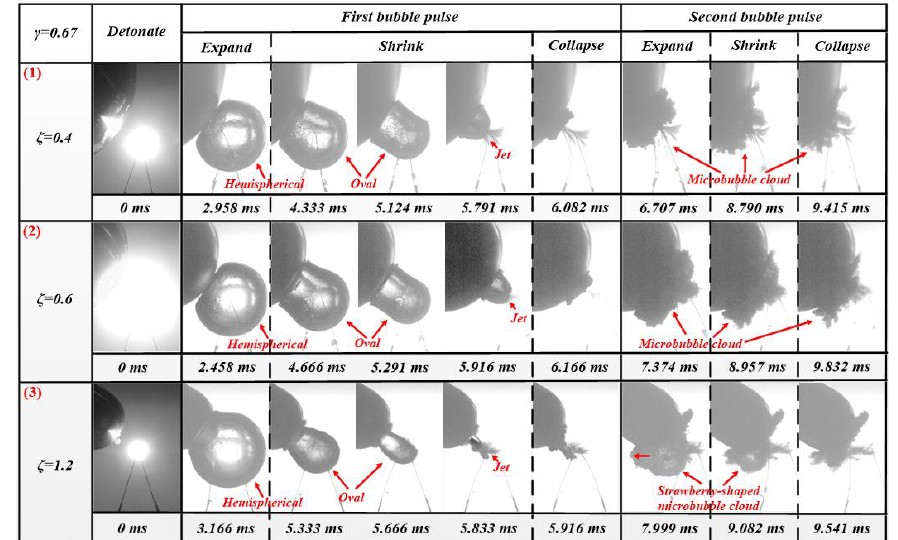
Figure 13. Type IV bubble pulsation process diagram. ( 1 ) The bubble pulsation process when ζ = 0.4 and γ = 0.67. ( 2 ) The bubble pulsation process when ζ = 0.6 and γ = 0.67. ( 3 ) The bubble pulsation process when ζ = 1.2 and γ = 0.67.